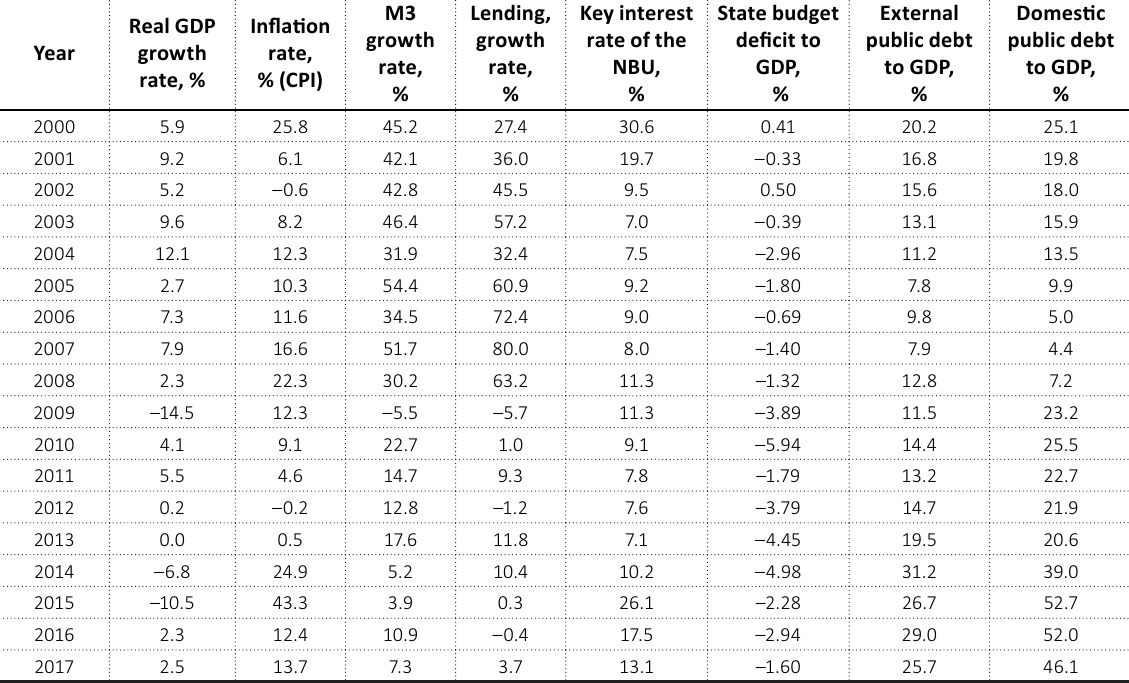
Table 1. The dynamics of the key macroeconomic indicators of Ukraine in 2000–2017 Source: Estimated by the authors using the NBU statistics and the State Statistics Service of Ukraine